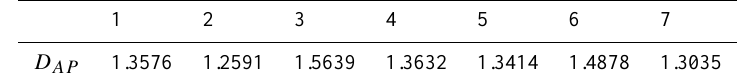
Table 2. Average D AP values of the pyrrhotite particles from the seven basalt samples.